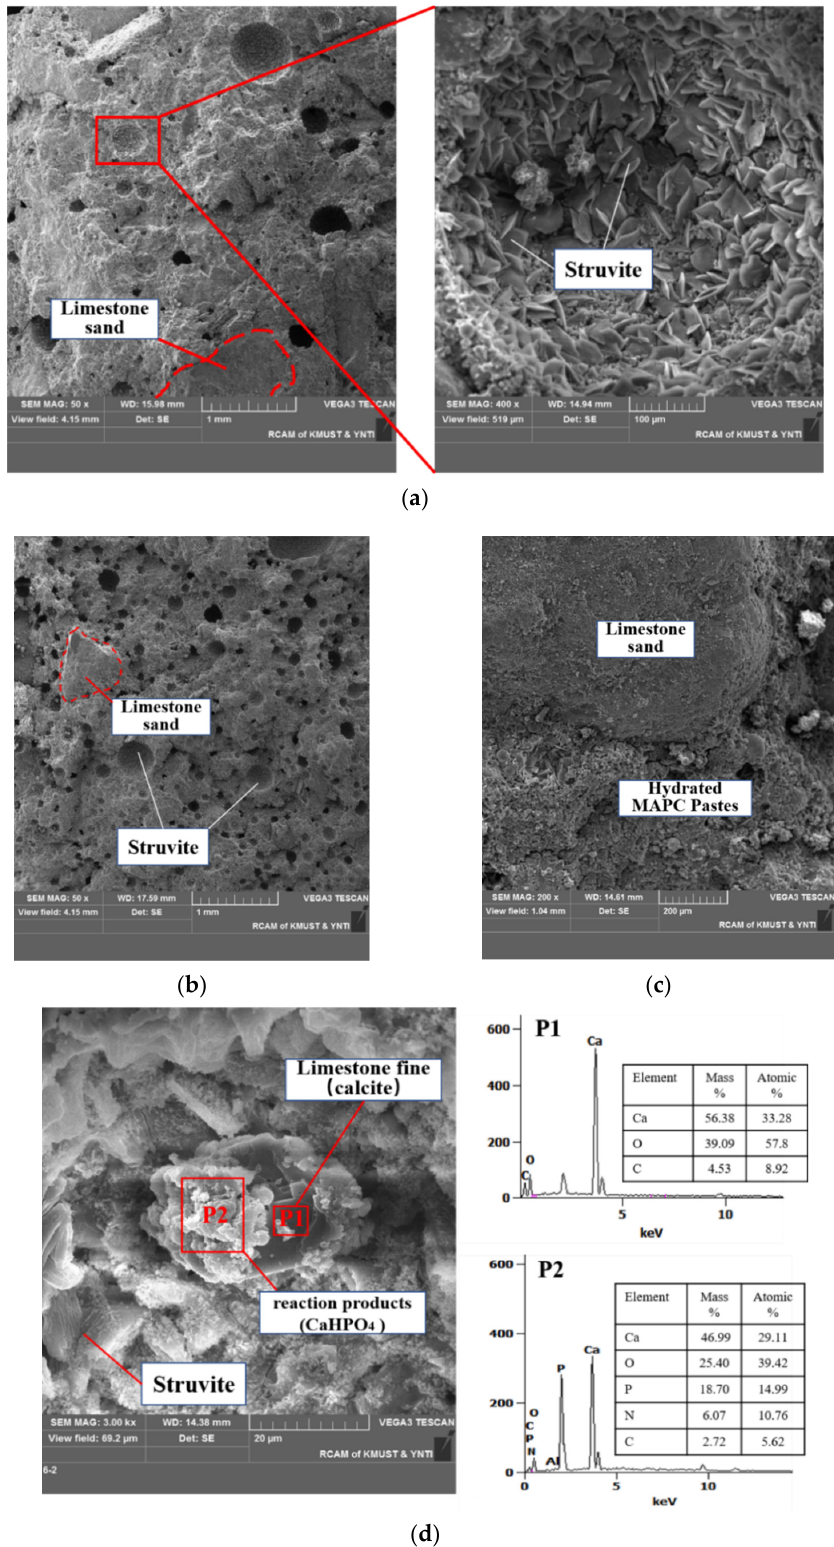
Figure 10. SEM observations of MAPC mortar samples with different contents of limestone fines ( a ) limestone fines at content of 0%; ( b ) limestone fines at content of 20%; ( c ) bonding interface between limestone sand and MAPC pastes; and ( d ) SEM image of limestone fine and its reaction products with ADP, and the corresponding EDX analysis results. products with ADP, and the corresponding EDX analysis